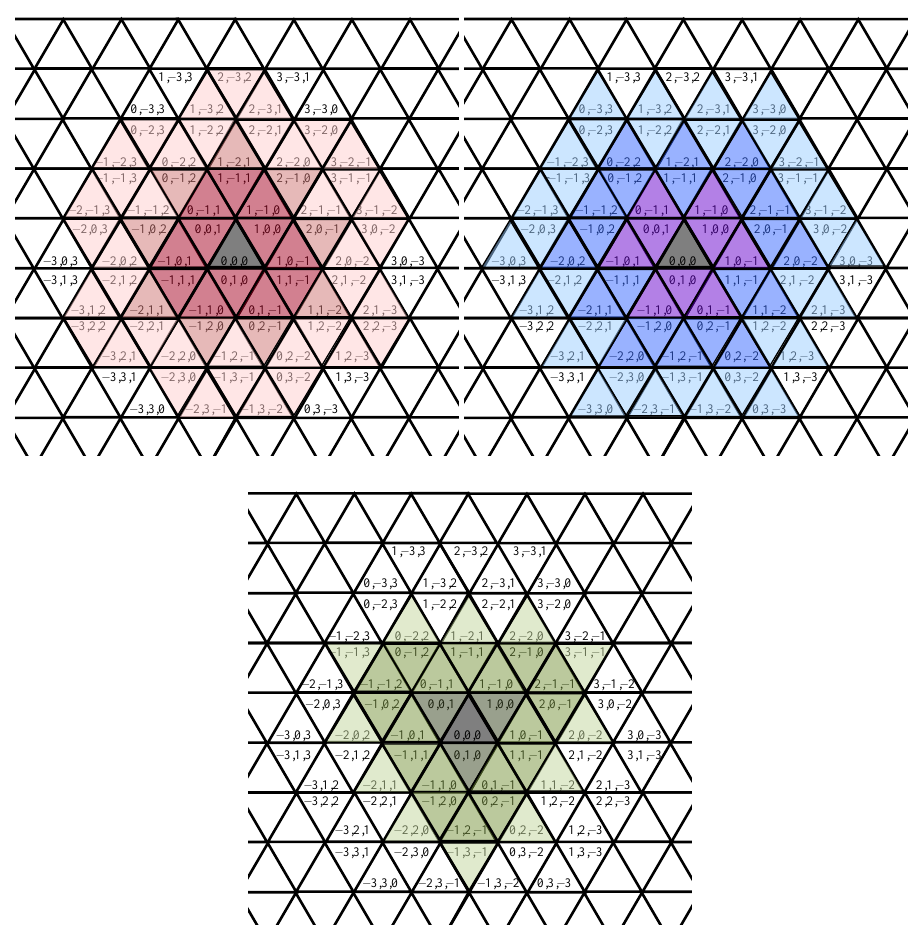
Figure 2. Digital disks with neighborhood sequence ( 3,1 ) on the left, with ( 2 ) on the right and with ( 1,3 ) at the bottom. The origin is marked with gray color, disks with radius 1 are dark shaded, disks with radius 2 are (dark and) medium color, while for disks with radius 3, all shaded pixels are